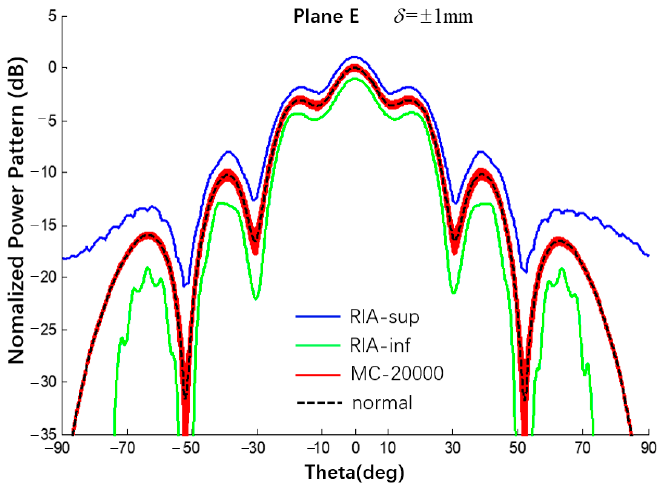
Figure 17. Interval power pattern of radius error of spherical CAAs (Plane E, uniform excitation).